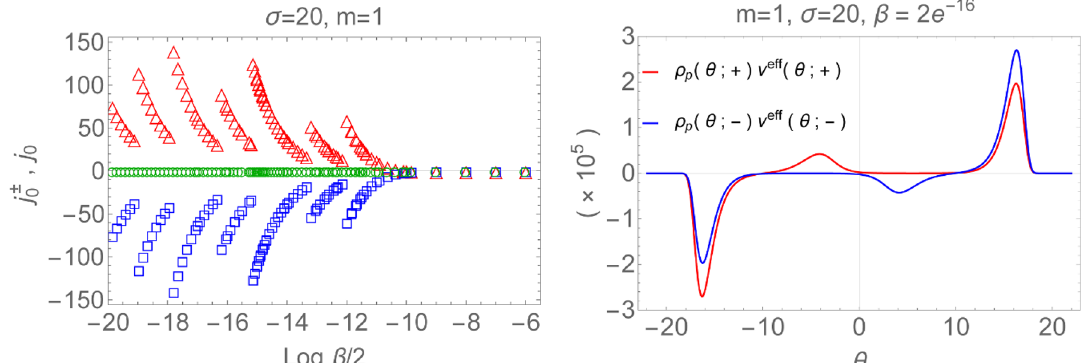
Figure 6 . Left panel: particle currents at equilibrium as functions of temperature. Right panel: the functions (cid:26) p ( (cid:18) ; (cid:6) ) v e(cid:11) ( (cid:18) ; (cid:6) ) for (cid:12) = 2 e (cid:0) 16 whose integration gives the particle currents. Here the vertical axis should be multiplied by a factor 10 5